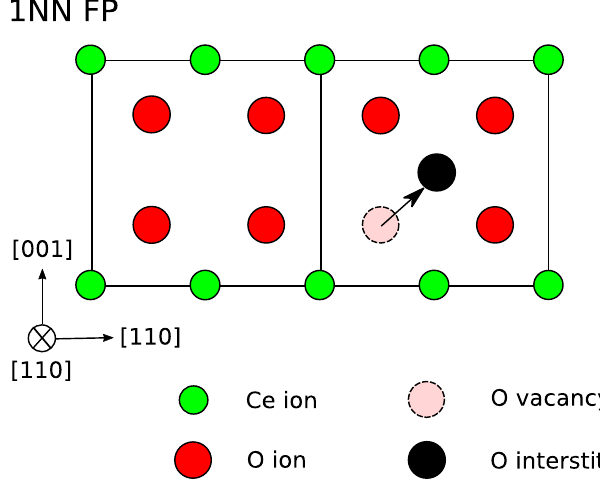
Figure 2. An example 1NN Frenkel pair.